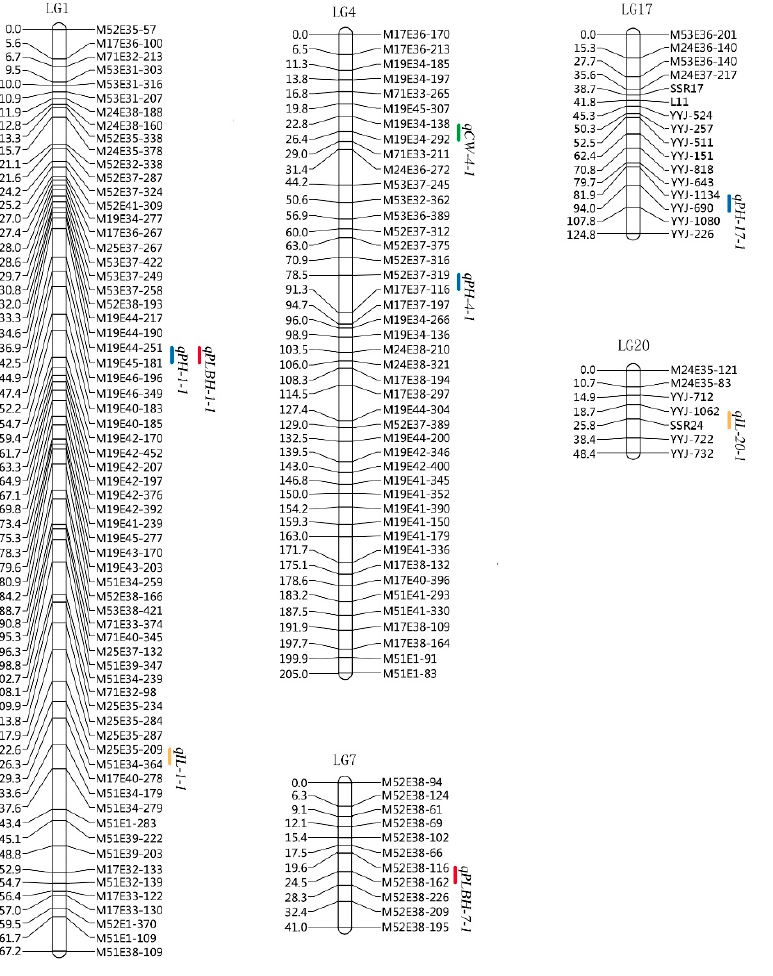
Figure 3. The results of the QTL test for the plant architecture traits. The right side shows the QTL name. QTL